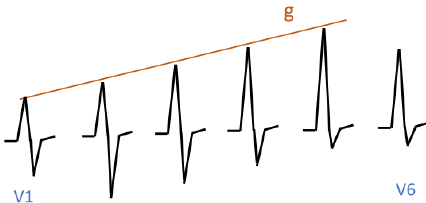
Figure 9. Normal R-wave progression.